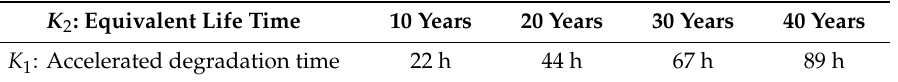
Table 2. Accelerated degradation times of the cable calculated by the Arrhenius equation.